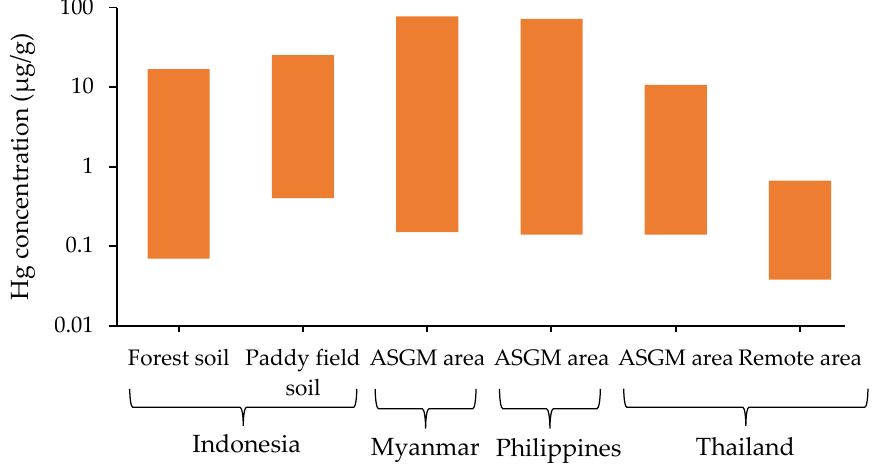
Figure 7. Hg concentrations in soil from Indonesia [33], Myanmar [17], the Philippines [27], and Thailand [31]. Each piece of data represents the Hg concentration of range value, which was from a single study.